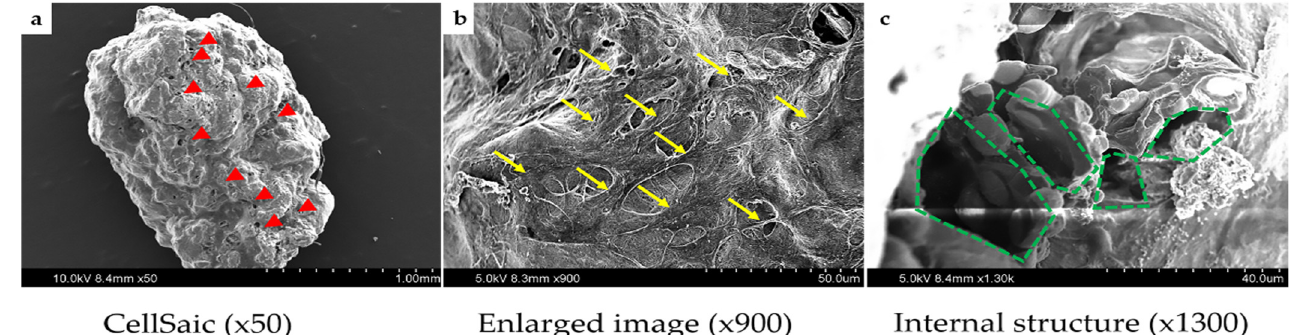
Figure 5. Morphology and structure of rDPSC-CellSaic under a scanning electron microscope. ( a ) Stem cells adhere to each other in rDPSC-CellSaic (the arrows point to the stomata); ( b ) Enlarged image (the arrows point to the cells); ( c ) Internal structure (polygons point to pores).